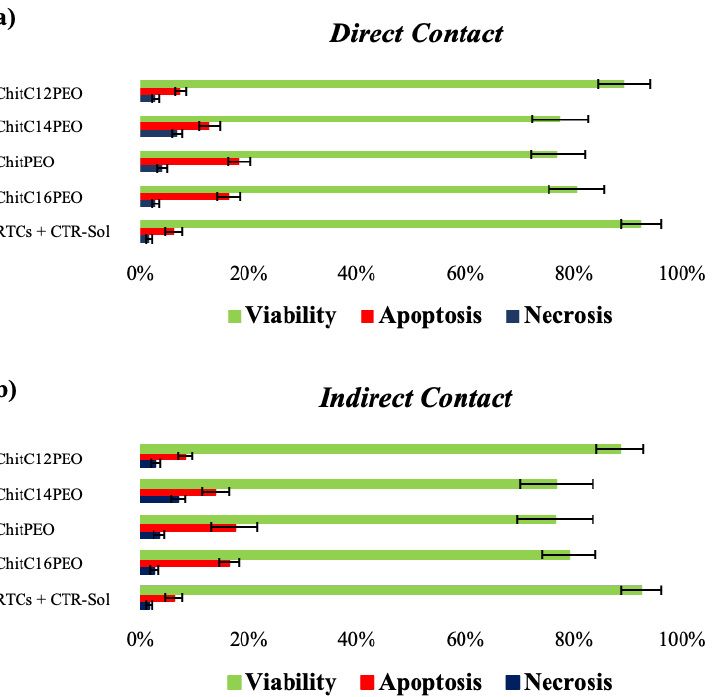
Figure 7. Percentage of Direct Contact ( a ) and Indirect Contact ( b ) viability, apoptosis and necrosis between RTCs in CTR-Sol incubated 24 h with the 4 test devices and RTCs incubated only with CTR-Sol.